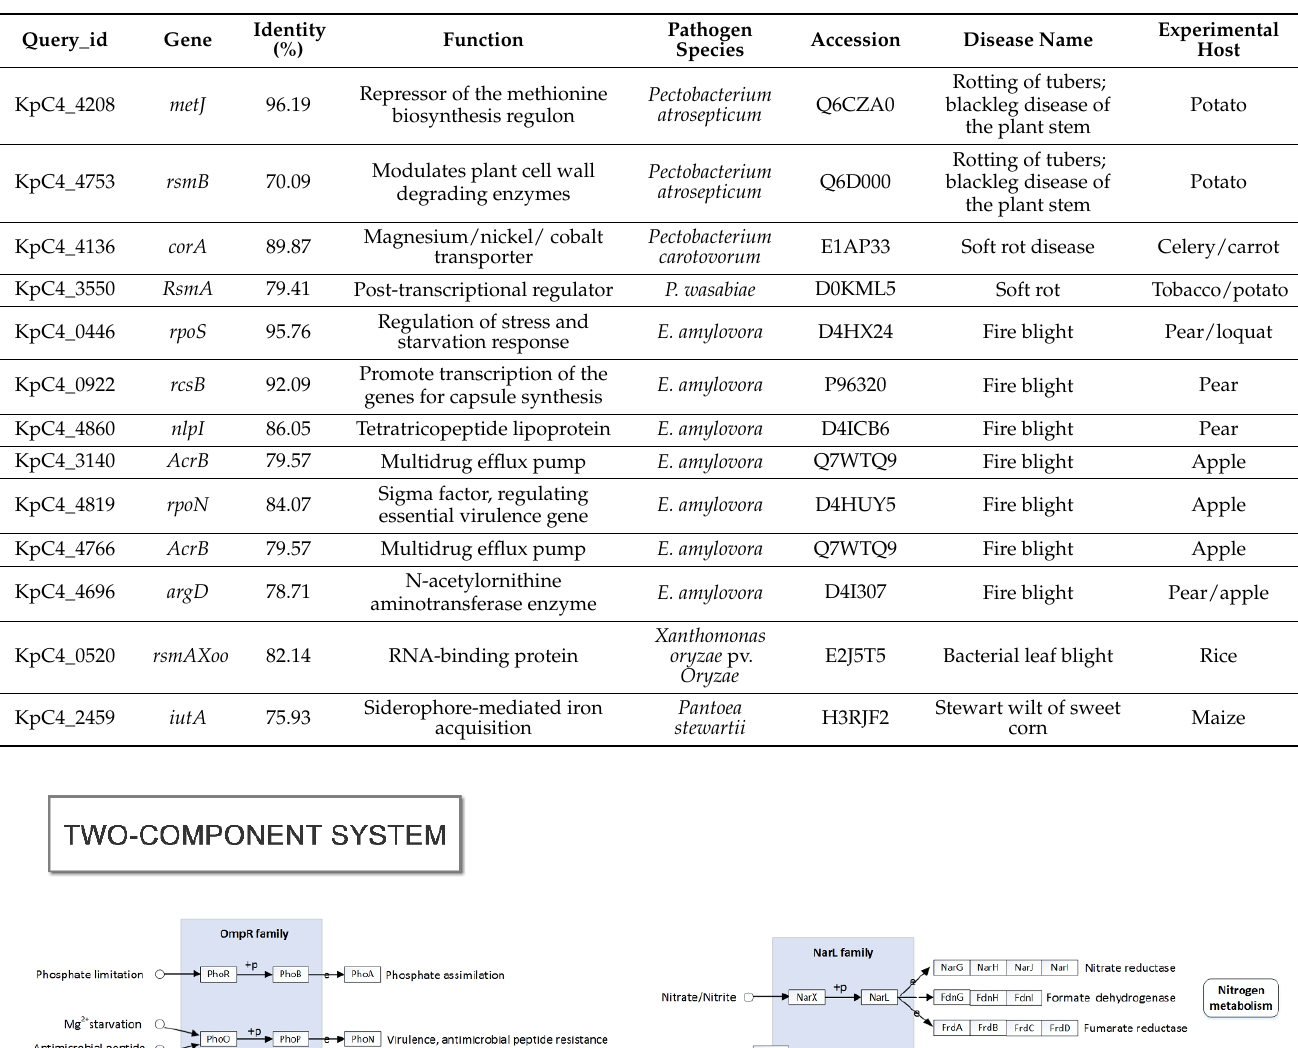
Table 2. Genes homologous with plant pathogens of KpC4.